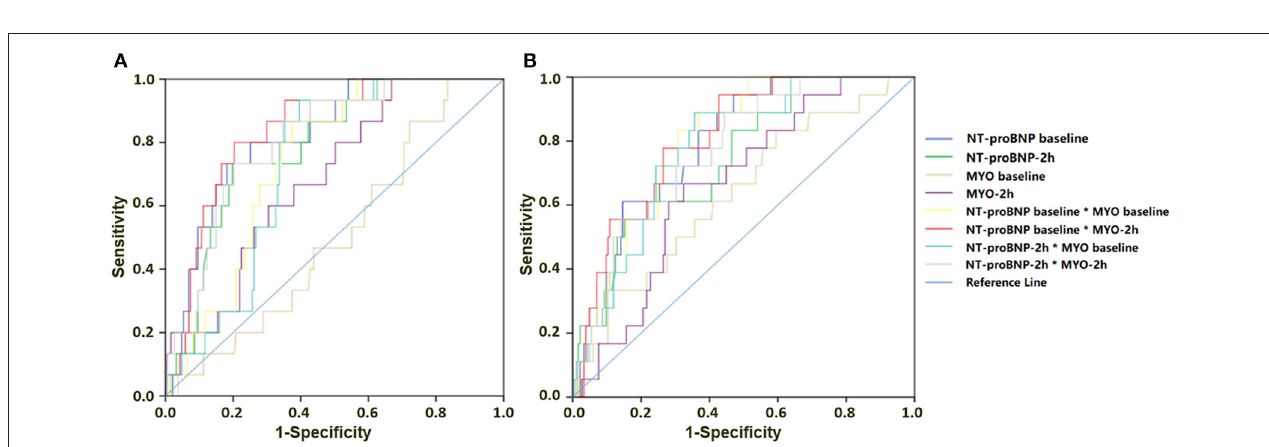
FIGURE 2 | Results of ROC analysis for NT-proBNP and MYO predicting complications within 30 days after surgery . (A) NT-proBNP and MYO concentrations for predicting complications ≥ CDC grade 3. (B) NT-proBNP and MYO for predicting major complications.